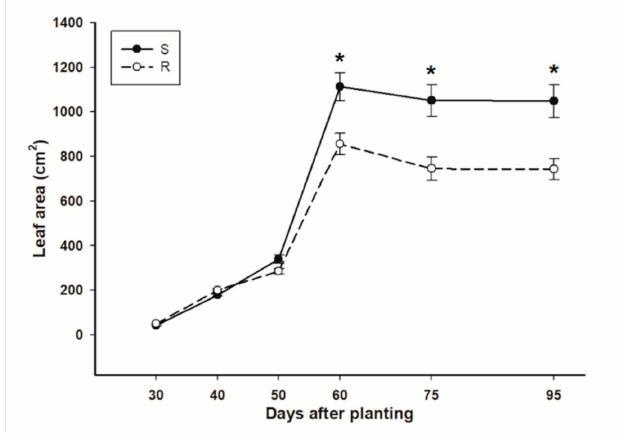
Figure 2. Leaf area per plant of imazamox-resistant (R) and susceptible (S) wild poinsettia plants. * indicates significant di ff erences at p < 0.05. Vertical bars ± standard error ( n = 30).